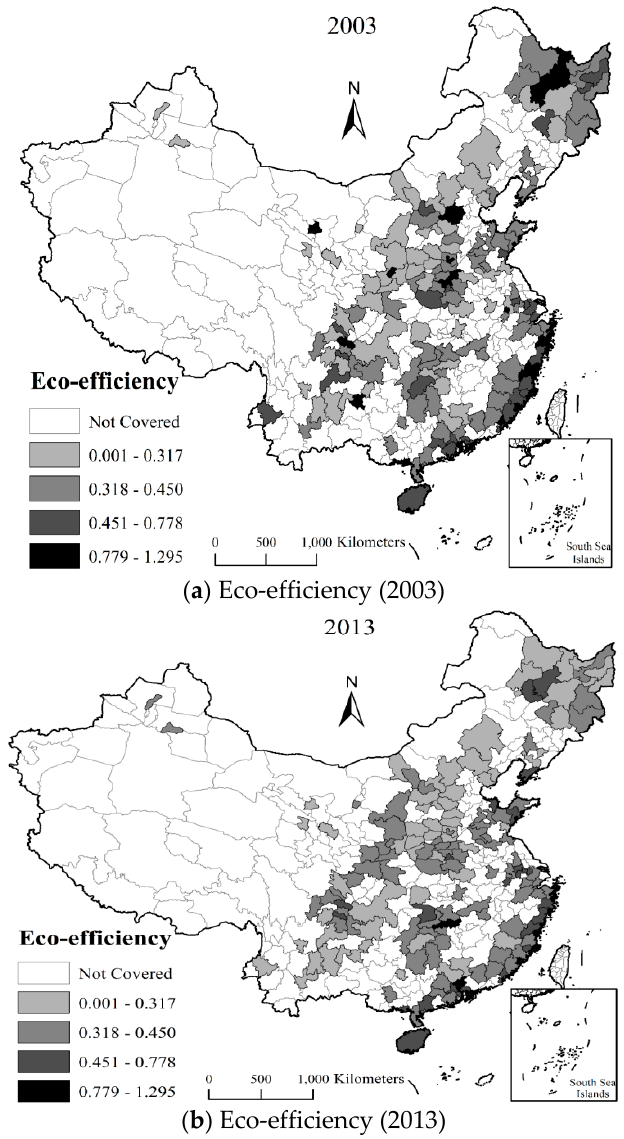
Figure 2. Spatial distribution of urban eco-efficiency in selected years (2003 and 2013).